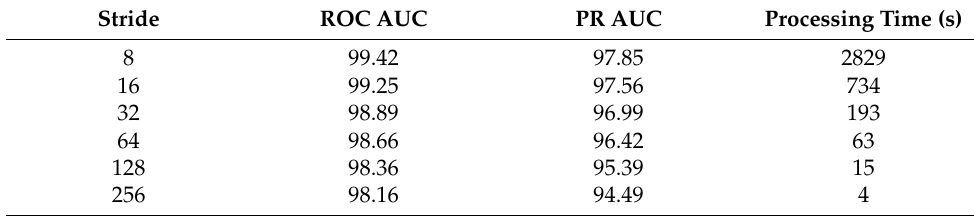
Table 4. ROC AUC, PR AUC, and processing time for 8, 16, 32, 64, 128, and 256 stride values.